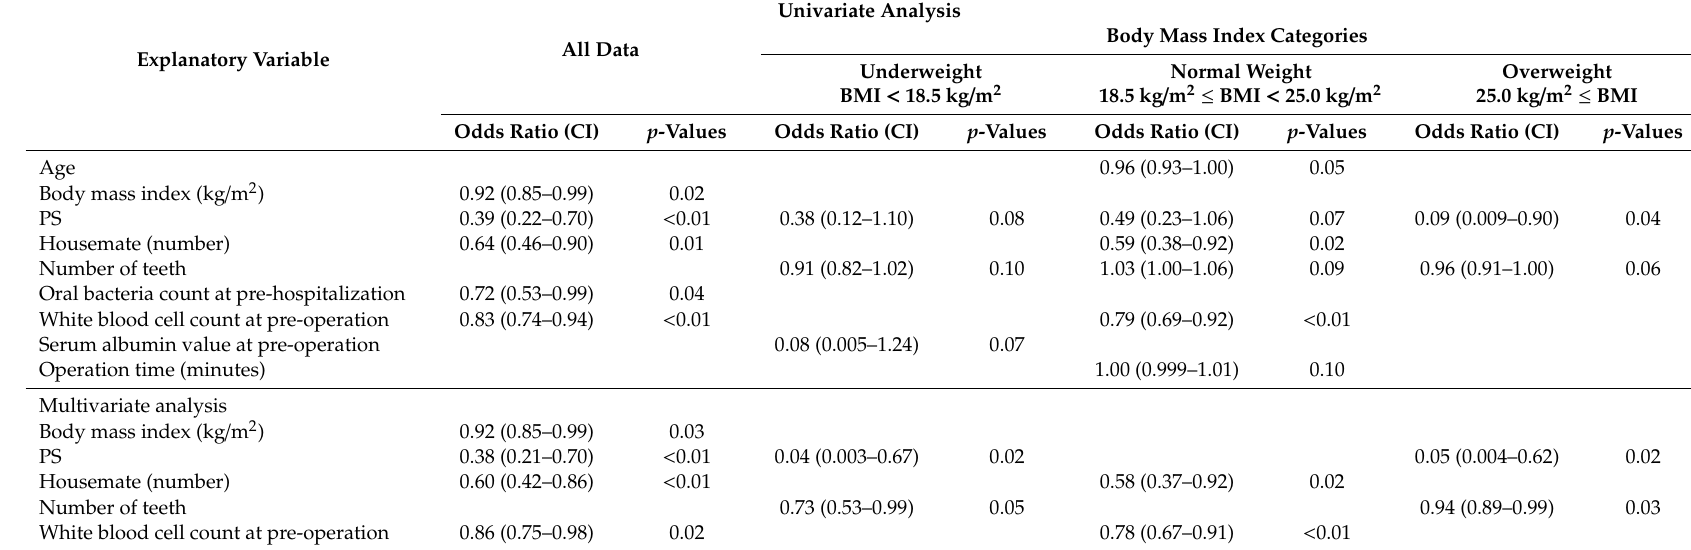
Table 2. Prognostic factors a ff ecting the duration of fever after operation by logistic regression